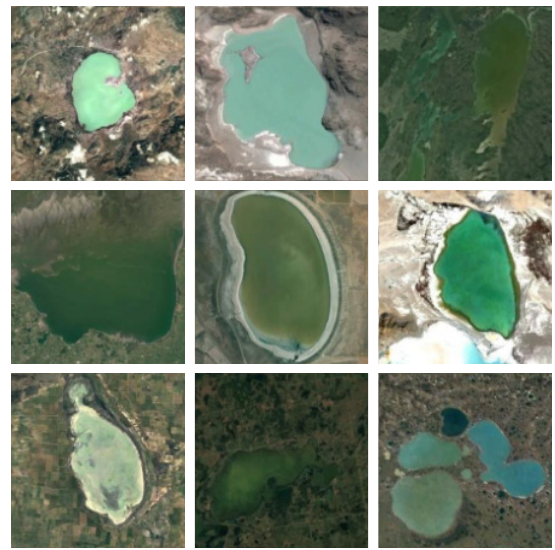
Figure 1. Satellite remote sensing data of related waters.